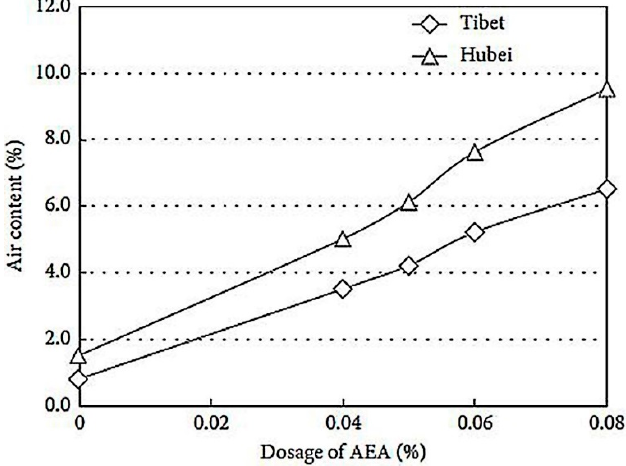
Figure 4. The relationship between dosage of AEA and air content under different AP.